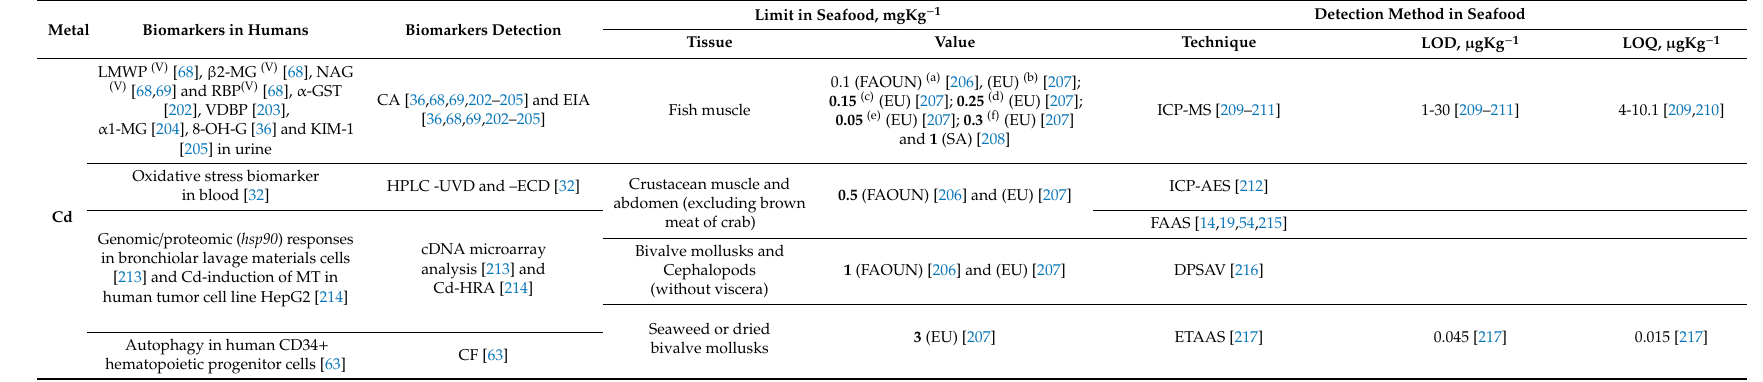
Table 2. Cadmium, mercury, lead and arsenic biomarkers: RBP—retinol-binding protein; LMWP—low molecular weight protein; β 2-MG— β 2-microglobulin; NAG—N-acetyl- β -d-glucosaminidase (NAG); α -GST—alpha- S-transferase; VDBP—vitamin D-binding